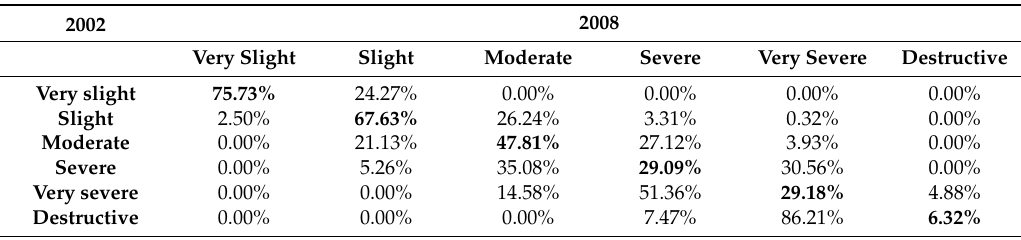
Table 5. The transition probability matrix of soil erosion intensity in the Wangjiagou agricultural watershed from 2008 to 2014.